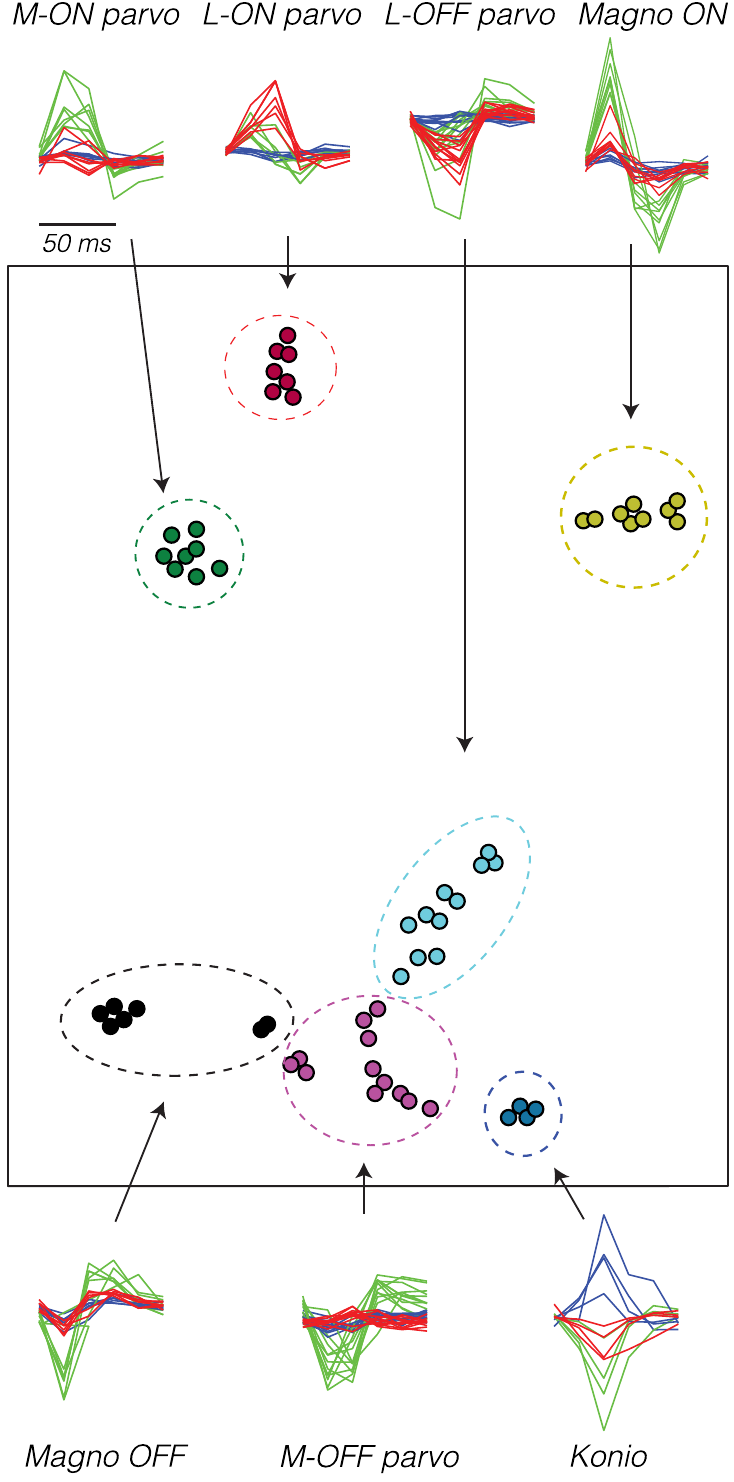
Fig 1. t-SNE of STAs from 58 LGN neurons [39]. Pixels in the white-noise stimulus that impinged on the RF were averaged to derive a 6 (frames) × 3 (color) temporal–chromatic STA for each neuron. STAs are plotted around the perimeter, and similar STAs have been superimposed. Arrows indicate the correspondence between STAs in time– color and t-SNE representations, which have been manually partitioned into seven clusters (dashed ellipses). Singular